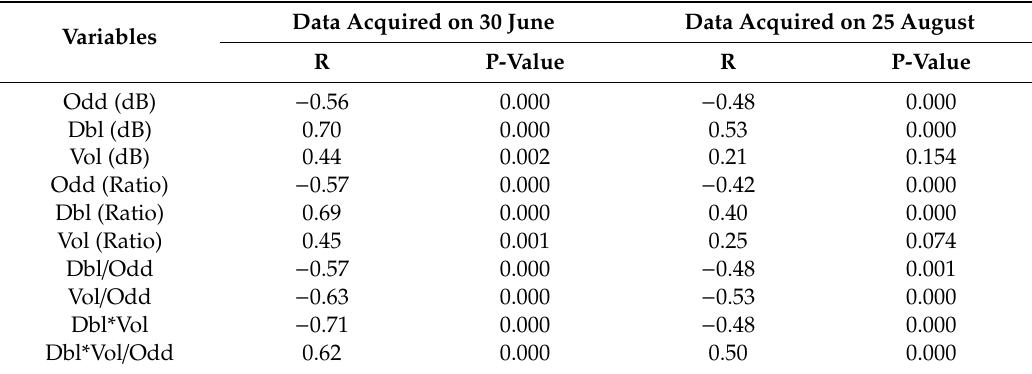
Table 3. Pearson’s correlation coe ffi cients R between the forest plot GSV and the polarimetric characteristics (Odd, Dbl and Vol indicate the surface scattering, double-bounce scattering and volume scattering, respectively; dB and Ratio indicate the polarimetric characteristics after the logarithm and ratio transformations).